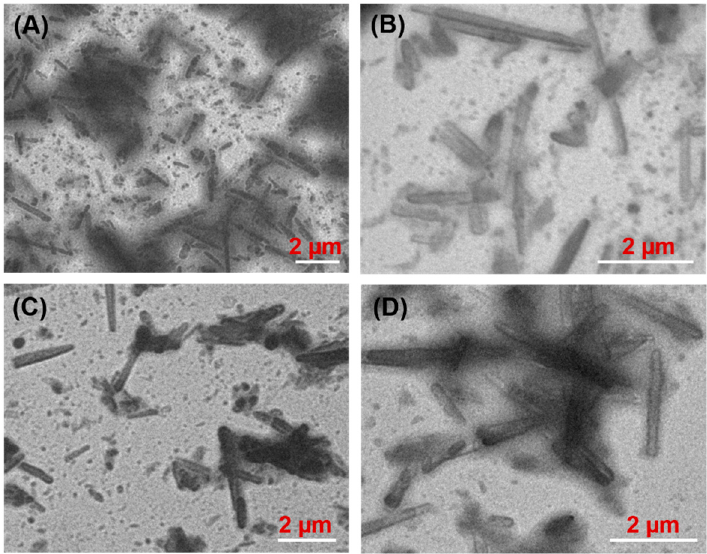
Figure 5. TEM images of oleogels prepared by C14-lys-C14 in olive oil ( A ), corn germ oil ( B ), soybean oil ( C ), and linseed oil ( D ).